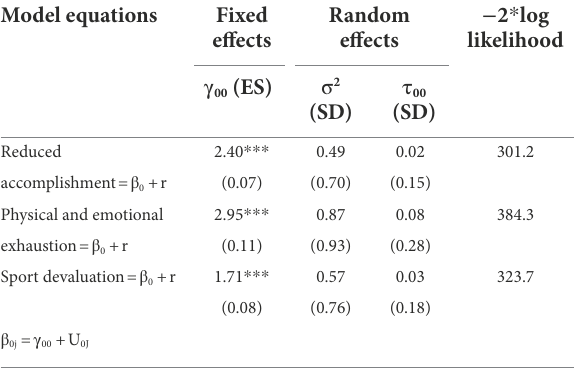
TABLE 2 Results of the null models. Model